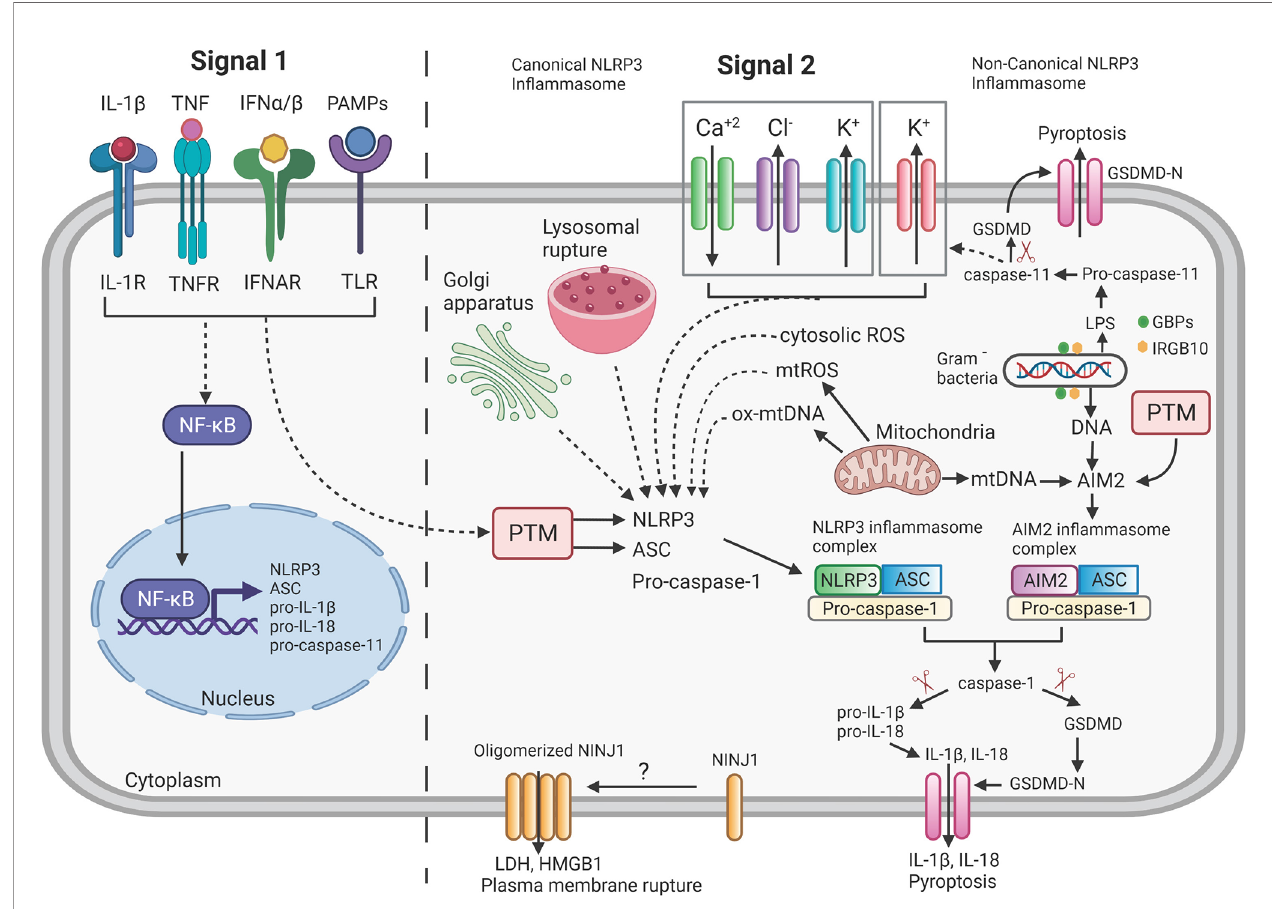
FIGURE 1 | Overview of mechanism of In fl ammasome signaling pathway. NLRP3 and AIM2 in fl ammasome activation requires two distinct signals: Signal 1 (priming signal, left) is induced by the detection of pathogen-associated molecular patterns (PAMPs) or endogenous cytokines by the Toll-like receptor (TLR) or cytokine receptors (IL-1R, TNFR, IFNAR) and thus leading to increased transcription of NLRP3, ASC, pro-IL-1 b , pro-IL-18 and pro-caspase-11 through activation of NF- k B. Signal 2 (activation signal, right) for the NLRP3 in fl ammasome is triggered by various stimuli such as potassium (K + ) ef fl ux, chloride (Cl - ) ef fl ux, calcium (Ca +2 ) in fl ux, oxidized mitochondrial DNA (ox-mtDNA), lysosomal rupture and intracellular reactive oxygen species (ROS) production. All these triggers lead to oligomerization and assembly of NLRP3 in fl ammasome complex. AIM2 directly recognizes either DNA released from Gram negative bacteria or mtDNA released from mitochondria and lead to assembly of AIM2 in fl ammasome complex. Activated in fl ammasome complexes (NLRP3 or AIM2) recruit and cleave pro-caspase-1 to active caspase-1 that further results in the proteolytic cleavage of pro-IL-1 b and pro-IL-18 to the mature forms IL-1 b and IL-18. Caspase-1 also cleaves gasdermin D (GSDMD) to its pore- forming N-terminal fragment GSDMD-N which results in pyroptosis. Ninjurin-1 (NINJ1) by unknown mechanism as indicated by “ ? ” oligomerizes and forms a pore to facilitate release of LDH, HMGB1 and the accumulation of these pores ultimately led to plasma membrane rupture which is not achieved by the GSDMD-N pores. Post-translational modi fi cations (PTM) of cytosolic sensors (NLRP3/AIM2) and adaptor protein (ASC) regulate the activity of in fl ammasome. Gram negative bacteria are lysed to releases LPS and DNA via a mechanism requiring various interferon-inducible Guanylate-binding proteins (GBPs) and IRGB10. The LPS binds to pro- caspase-11 to initiate autocleavage into active caspase-11 which further cleaves GSDMD to GSDMD-N and results in pyroptosis (indicated as Non-Canonical NLRP3 in fl ammasome) and increased ef fl ux of K + , thus further activating the canonical NLRP3 in fl ammasome pathway (dashed lines = indirect interaction; solid lines = direct interaction; arrowhead = activation). Created with